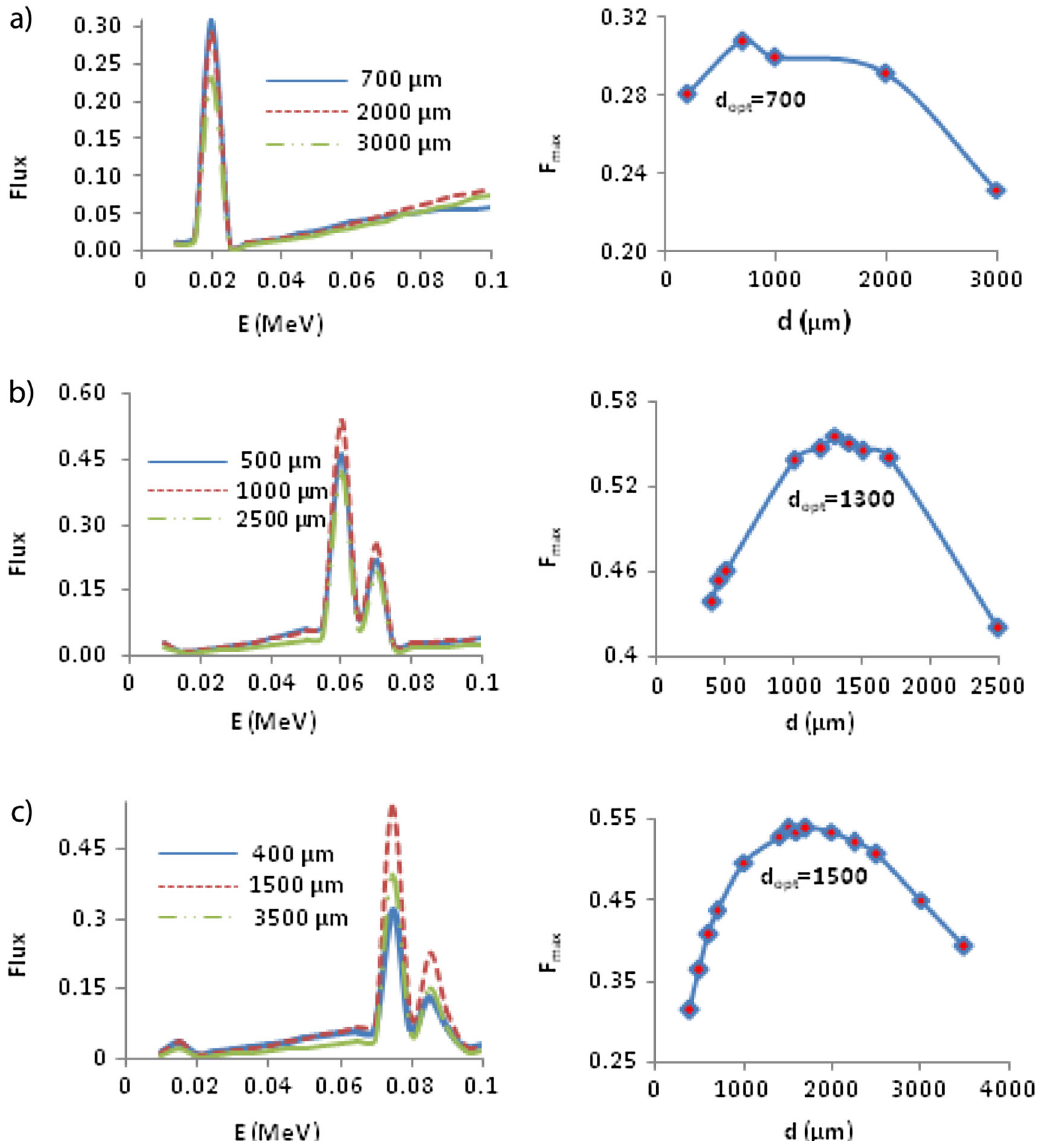
FIG. 5. The x-ray fluxes produced by the q -monoenergetic profile versus energy in several thicknesses (left), and the maximum x-ray flux versus thickness (right) for three targets (a) Mo, (b) W, and (c)